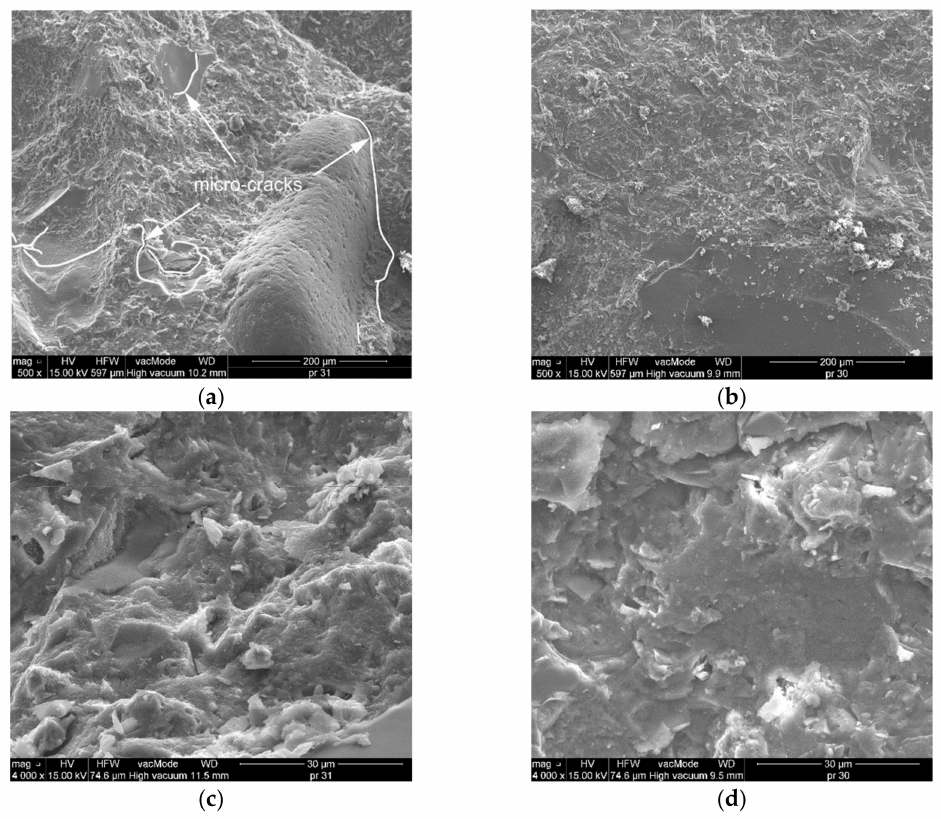
Figure 6. SEM micrographs of UHPC specimens. ( a ) Reference mixture (mag. 500 × ); ( b ) 5% replacement of WFS (mag. 500 × ); ( c ) Reference mixture (mag. 4000 × ); ( d ) 5% replacement of WFS (mag. 4000 ×